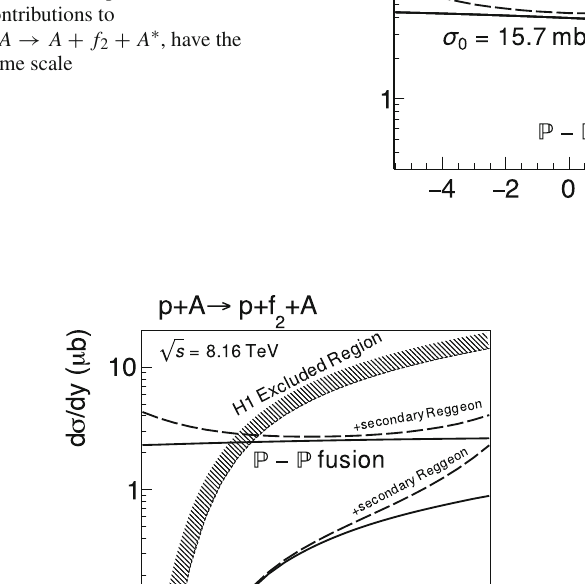
Fig. 2 The shift of the continuous curves show the effect of changing σ tot ( f 2 N ) from 0 to the VDM form of (17) with σ 0 = 15 . 7 mb and (cid:10) = 0 . 055. The dashed curves show the possible effect of including a secondary Reggeon contribution. Note that the two plots, showing respectively the Pomeron- and photon-induced contributions to AA → A + f 2 + A ∗ , have the same scale